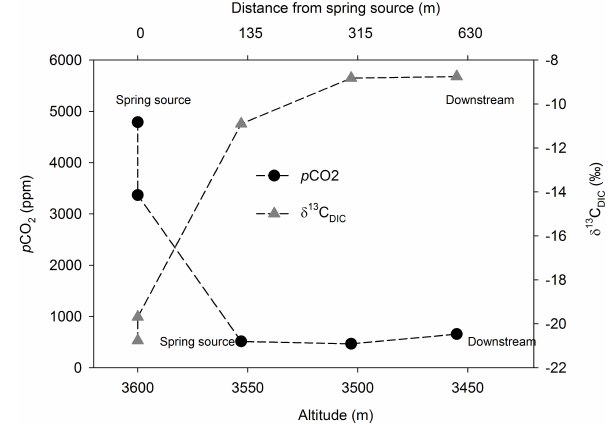
Fig. 15. Observed total alkalinity against modelled total alkalinity along the Tana River basin.